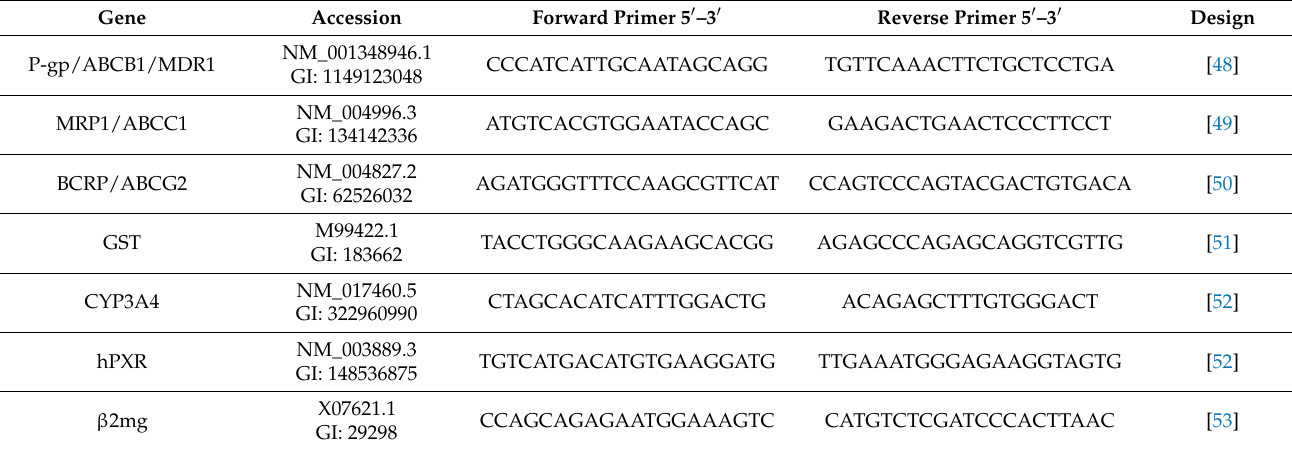
Table 4. Primers used for real-time